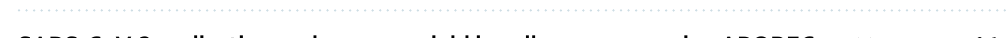
Figure 5. SARS-CoV-2 replication and virion production in cells expressing APOBECs. ( A ) Overview of experiments for SARS-CoV-2 replication and viral production in the presence of APOBECs. The Caco-2 stable cell lines were constructed to express A1 + A1CF, A3A, or A3G under a tetracycline-controlled promoter. The Caco-2-APOBEC stable cell lines were then infected with SARS-CoV-2 (MOI = 0.05), and the viral RNA replication and progeny production were measured at different time points. ( B ) Effect of each APOBEC expression on SARS-CoV-2 viral RNA replication. Measurement of relative viral RNA abundance at different time points after viral infection of the Caco-2-APOBEC stable cell lines expressing A1 + A1CF, A3A, or A3G. The viral RNA abundance was measured using real-time quantitative PCR (qPCR) to detect RNA levels by using specific primers to amplify three separate viral regions, the Nsp12 , S, or N coding regions (see Methods in SI). ( C ) Effect of each APOBEC expression on SARS-CoV-2 progeny production. Infectious viral progeny yield harvested in the medium at 48 h and 72 h post-infection was determined by plaque assay (see “Methods”). In panel ( B ) and ( C ), statistical significance was calculated by unpaired two-tailed student’s t-test with P -values represented as: P > 0.05 = not significant, ***P <